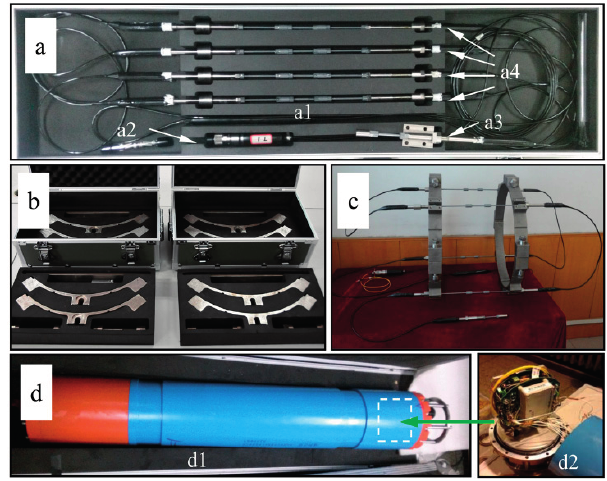
Figure 1. The developed bundle-structure riser stress sensor system. ( a ) A string of five FBG sensors: elastic elements ( a1 ), an optical fiber connector ( a2 ), a FBG environment-compensating sensor ( a3 ), four FBG strain sensors ( a4 ); ( b ) two unassembled ring-shaped ties; ( c ) the assembly of five FBG sensors and two ring-shaped ties; ( d ) housing ( d1 ) and demodulation module ( d2